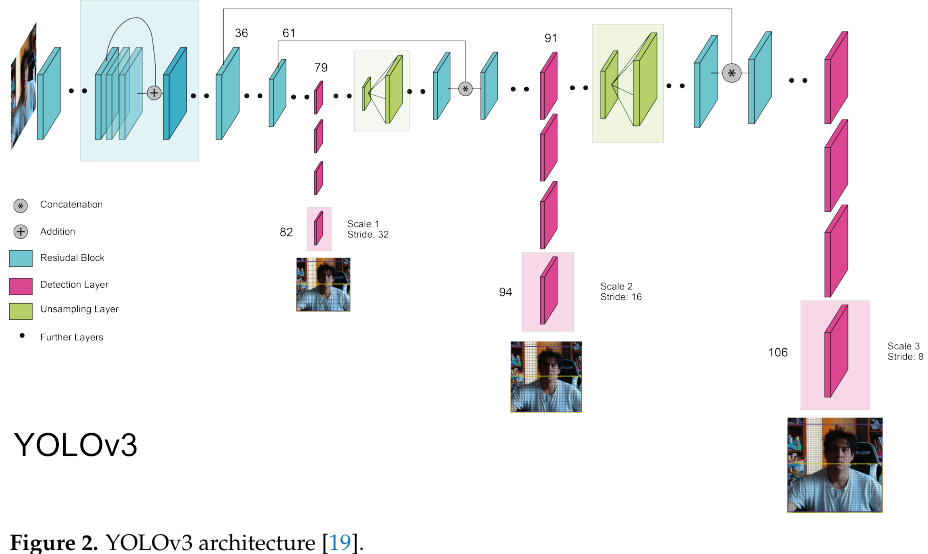
Figure 2. YOLOv3 architecture